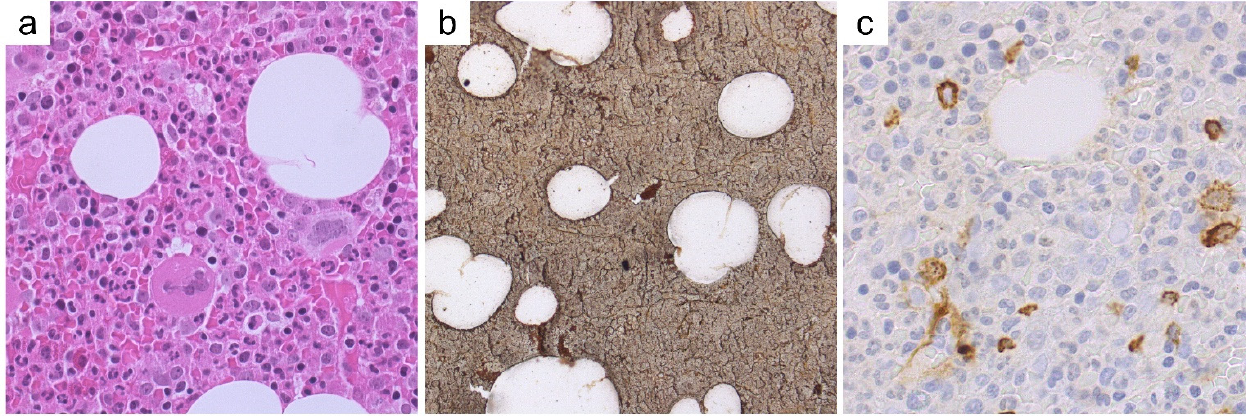
Figure 5. Representative histological features of case #7. BM biopsy from case #7 shows panmyelosis with normal myeloid- to-erythroid ratio, mildly left shifted granulopoiesis and increased, mature-looking megakaryocytes ( a ; H/E, 200 × ) with unremarkable reticulin network ( b ; Gomori silver stain, 200 × ) and a minor increase in CD34+ blasts ( c ; 200 ×